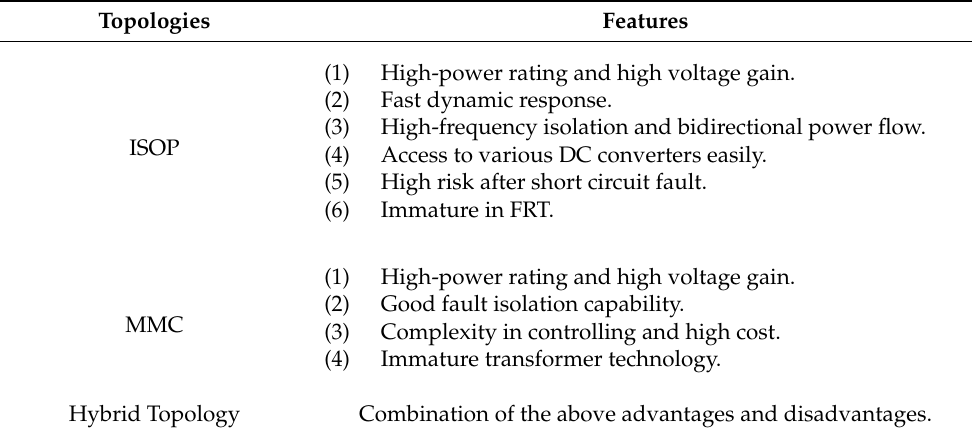
Table 1. Comparison of the DCT